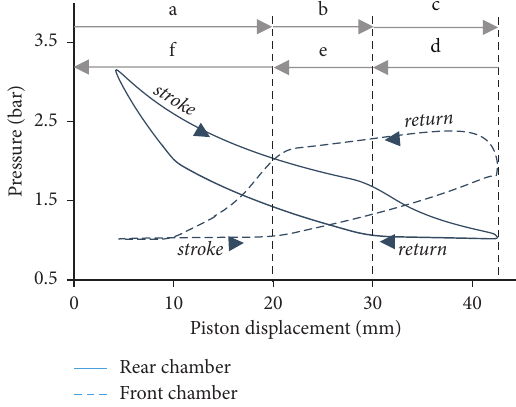
Figure 8: Curve between piston displacement and